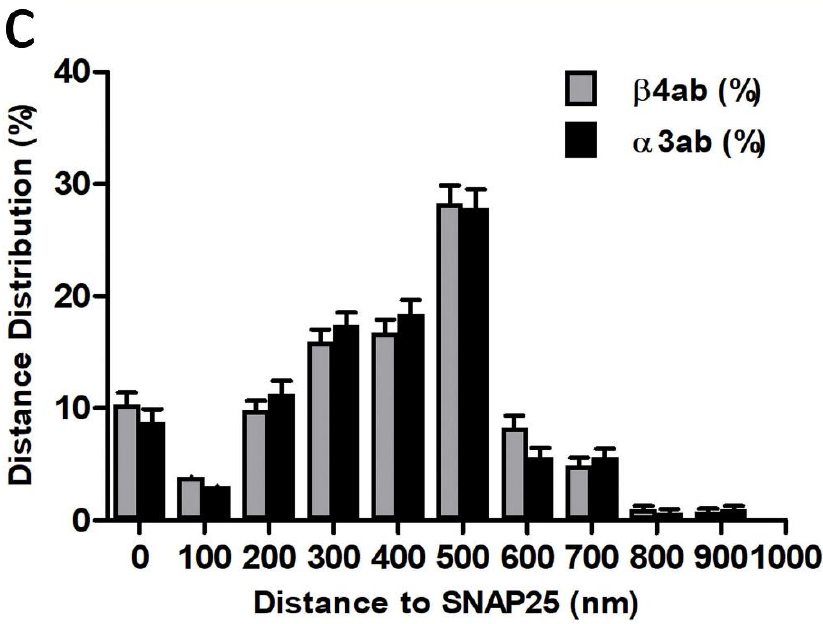
Figure 1. Peripheral distribution of endogenous α 3 or β 4 nAChR subunits to EGFP-SNAP25. ( a ) Cortical layer (TOP) of a cell expressing EFGP-SNAP25 (green) and inmunolabeled with antibody anti- β4 Atto -594 (red). ( b ) Similar image of a cell expressing EFGP-SNAP25 (green), but immunolabeled with the anti- α 3 antibody and revealed with the appropriate secondary antibody Alexafluor-546 (red). ( c ) A comparison of the average distance between the centroids of each immunologically identified α3 or β4 nAChR subunits and the centroids of the nearest EGFP-SNAP25. All of the records were obtained using sequential laser excitation and acquisition. Bars indicate 1 µm.